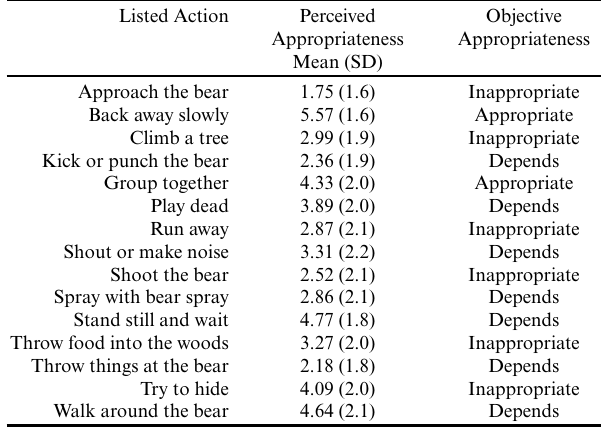
Table 4 . Perceived and objective appropriateness of listed